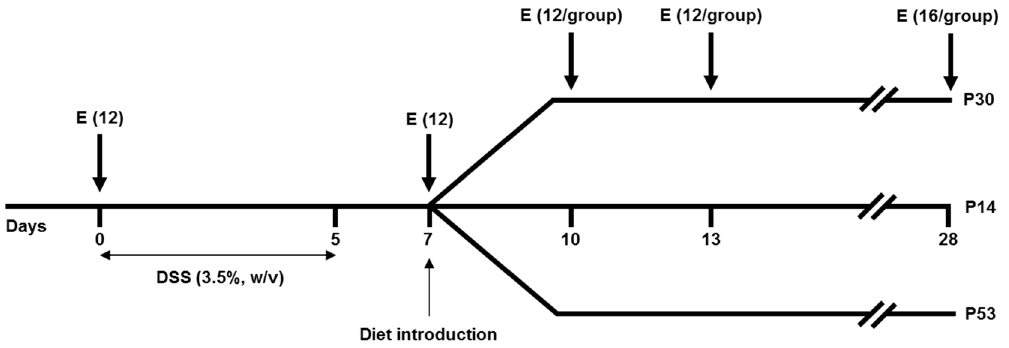
Figure 1. Schematic representation of the experimental design. Mice received either P14 (14% of proteins), P30 (30% of proteins) or P53 (53% of proteins) diet from D7 to D28. Mice were euthanized (E) at day 0 , 7 , and during the resolution phase at days 10 , 13 and 28 .